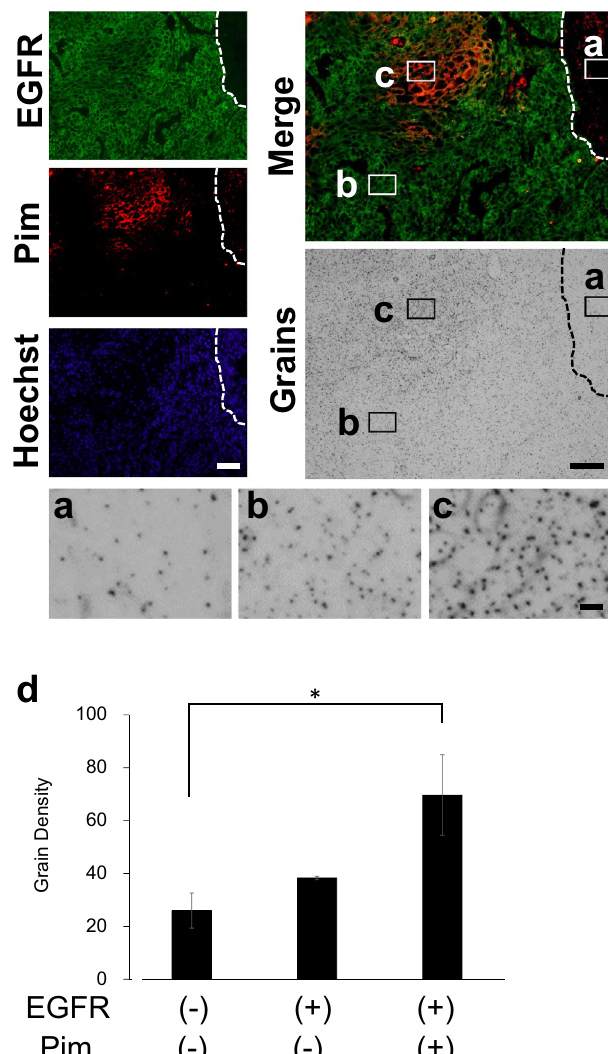
Figure 5. 18 F-FDG accumulation in hypoxic cells expressing EGFR. The dotted line shows the boundary between the tumor and the skin area. ( a ) Magnified view of the micro-autoradiography image showing the pimonidazole- and EGFR-negative skin area, ( b ) pimonidazole-negative and EGFR-positive area, and ( c ) pimonidazole- and EGFR-positive area. ( d ) Determination of grain density in the pimonidazole- and EGFR- positive and negative areas, focusing on the same-sized ROIs (n = 3, mean ± SEM, Tukey’s multiple comparison, *: p < 0.05). Pim: Pimonidazole. Bars: 100 μm (EGFR, Pimonidazole, Hoechst, Merge and Silver grains), 10 μm ( a – c